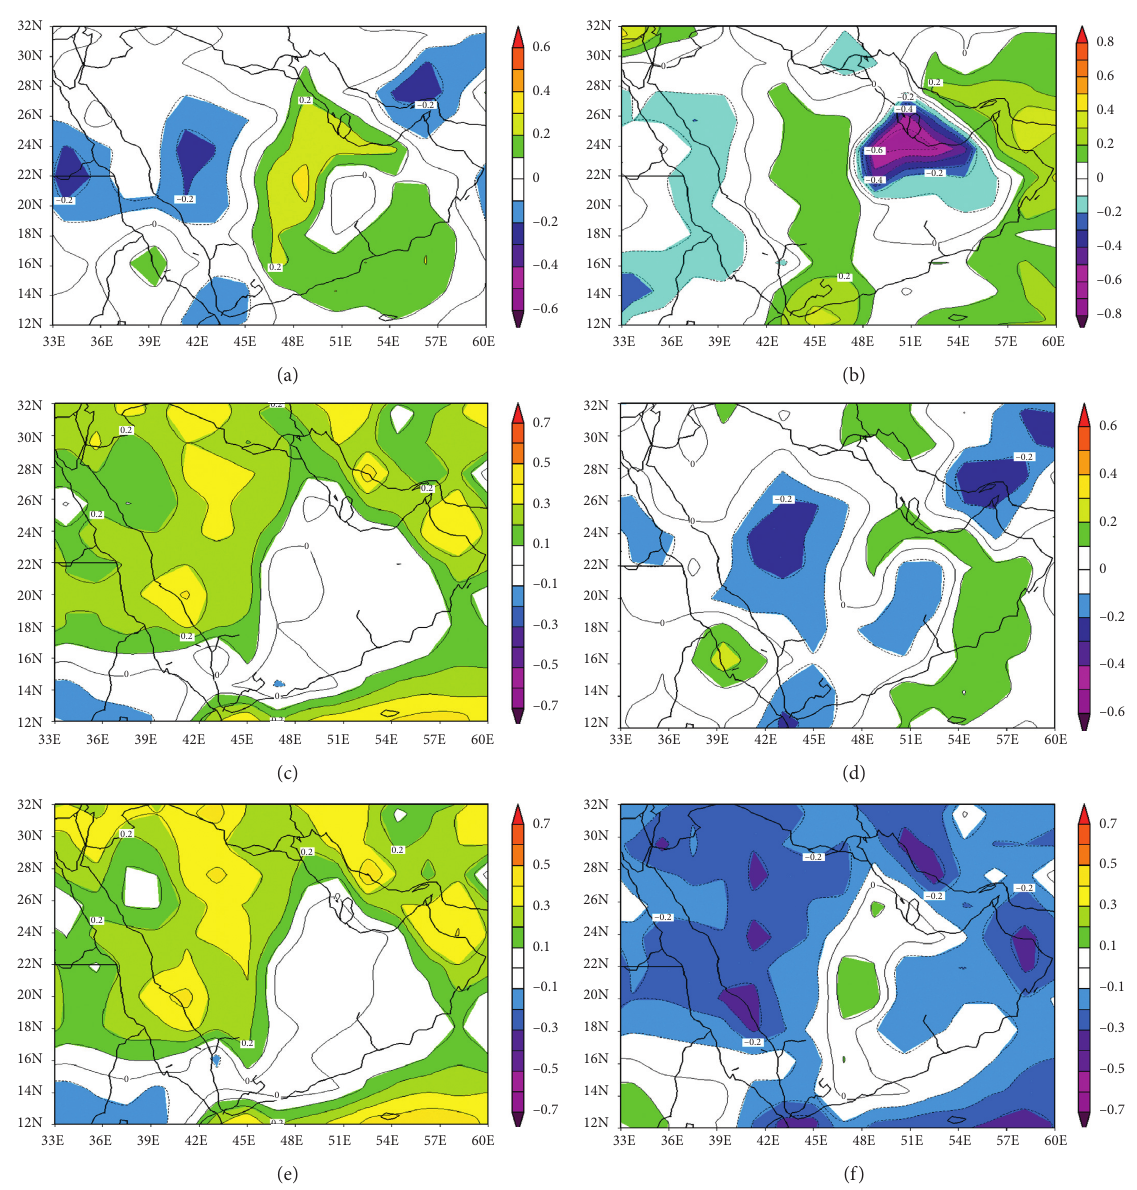
Figure 7: The distribution of the correlation coefficients between the PR over the Arabian Peninsula, including SA, and the climatic indices for October during the study period (1948–2018). (a) AO. (b) GSAT. (c) MEI. (d) NAO. (e) Nino 3.4. (f) SOI (NCEP/NCAR Reanalysis NOAA/ESRL Physical Sciences